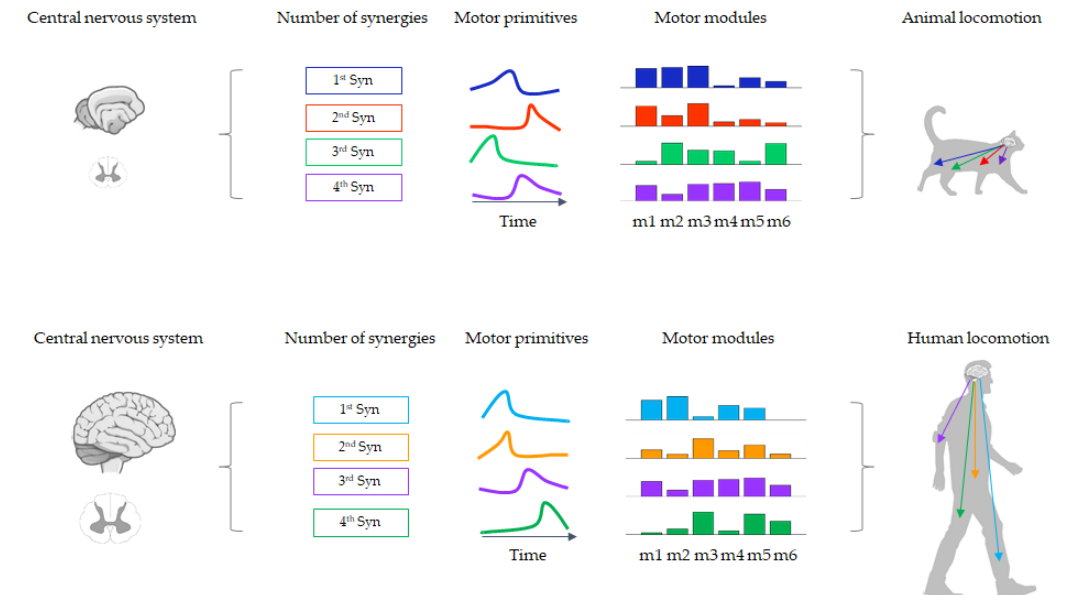
Figure 1. A representative example of the number of synergies, motor primitives and motor modules in animals and humans while walking.